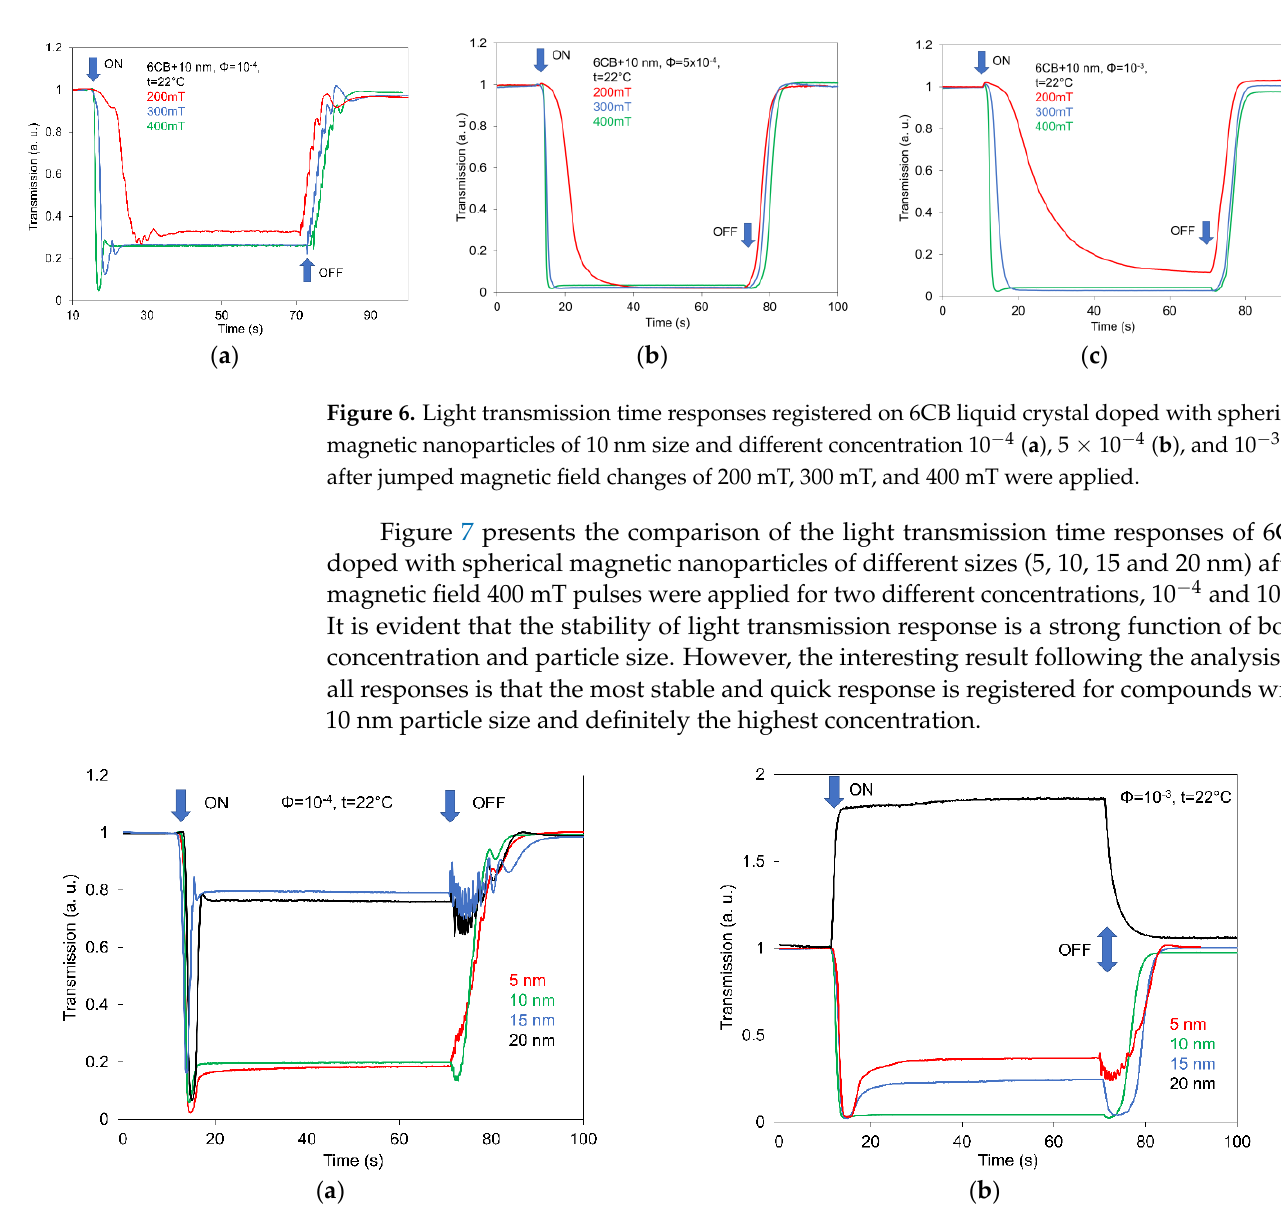
Figure 6. Light transmission time responses registered on 6CB liquid crystal doped with spherical magnetic nanoparticles of 10 nm size and different concentration 10 − 4 ( a ), 5 × 10 − 4 ( b ), and 10 − 3 ( c ) after jumped magnetic field changes of 200 mT, 300 mT, and 400 mT were applied.